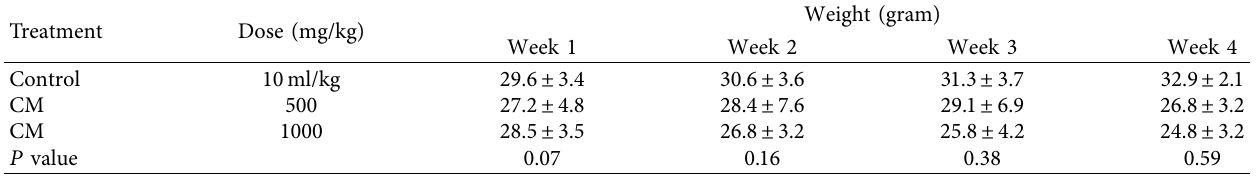
Table 1: Changes in body weight of mice after treatment with 500mg/kg and 1000mg/kg b.w. of C. martini essential oil. Treatment